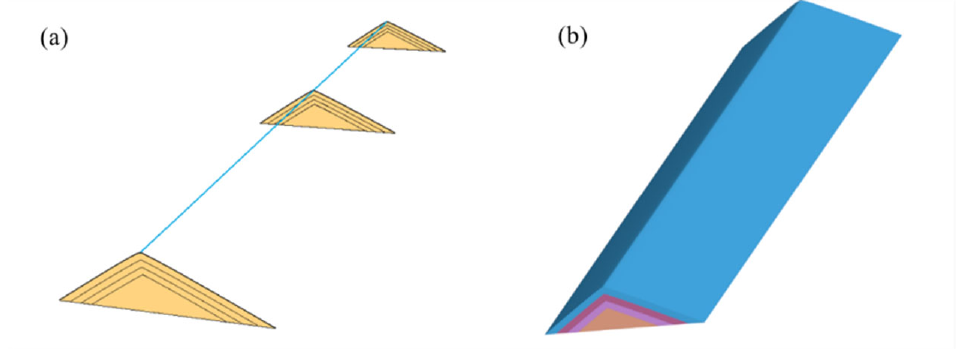
Figure 15. 3D symbol modeling process of Fangdou Mountain: ( a ) sections and hinge line of Fangdou Mountain, and ( b ) 3D symbol model of the Fangdou Mountain chevron fold.